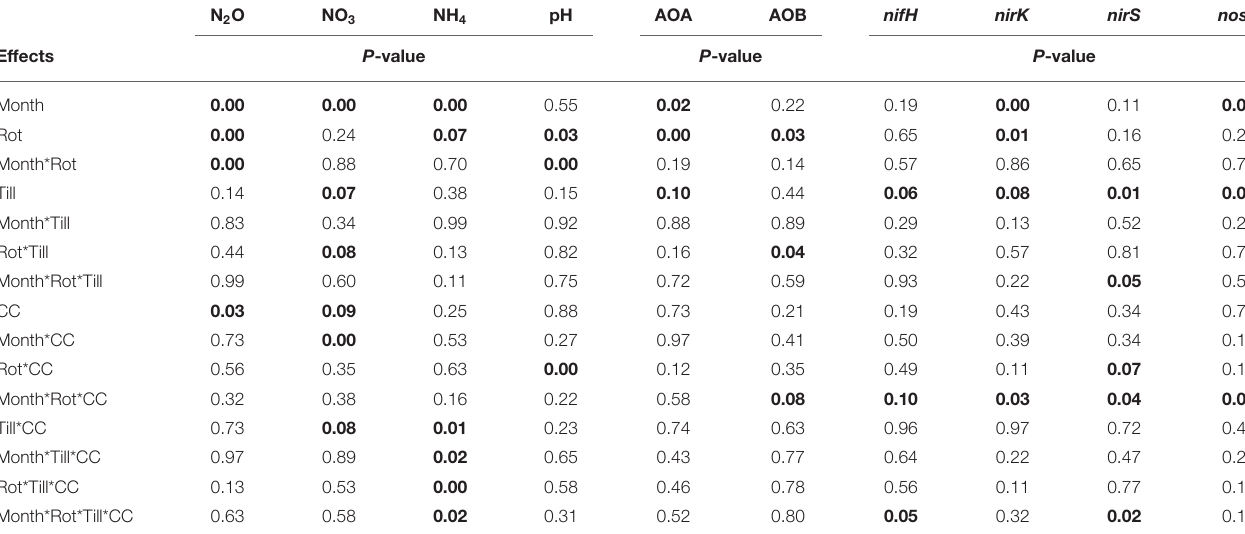
TABLE 1 | Analysis of variance (ANOVA) results for the effects of month, crop rotation (Rot), tillage (Till), and cover crop (CC) and their interactions for nitrous oxide (N 2 O), available nitrogen (NO 3 and NH 4 ), pH, ammonia-oxidizing archaea (AOA), ammonia-oxidizing bacteria (AOB), nifH , nirK , nirS , and nosZ .